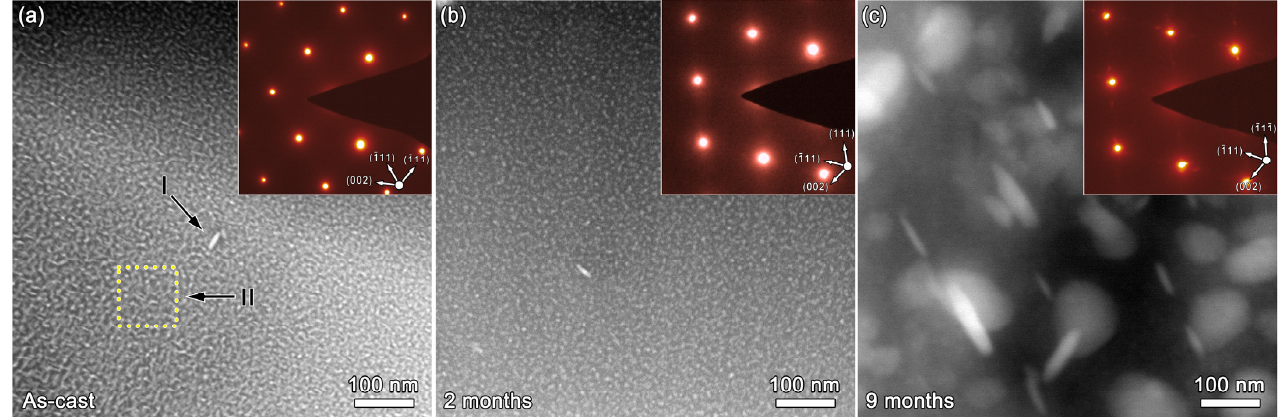
Figure 5. Typical Z-contrast images respectively recorded from ( a ) as-cast, ( b ) 2 months, and ( c ) 9 months natural-aged Al-20Zn-3Cu alloys. Corresponding electron diffraction patterns are presented in the insets.